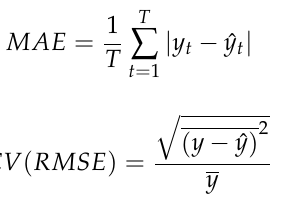
red. Dashed red lines are thresholds corresponding to a significance level of 10% (see Appendix